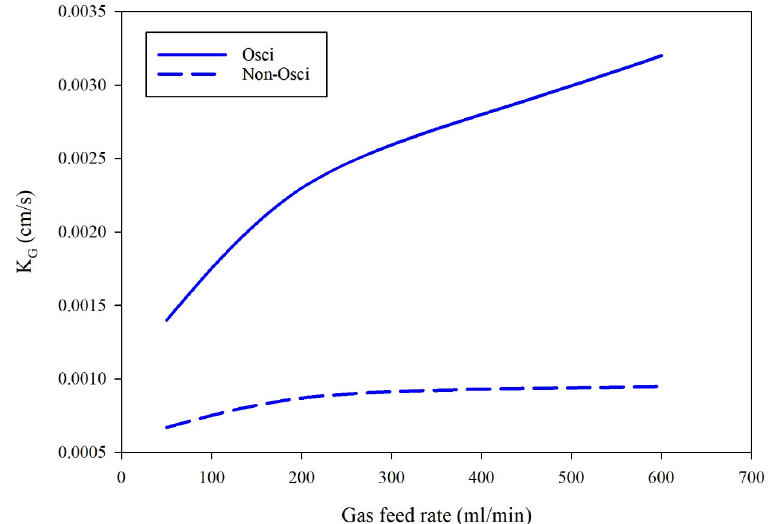
Figure 7. Effect of gas feed rate on the CO 2 overall mass transfer coefficients under the optimum oscillating frequency (0.05) and in normal conditions at a constant liquid feed rate of 10 mL/min. Gas was introduced to the shell side and solvent into the tube side.